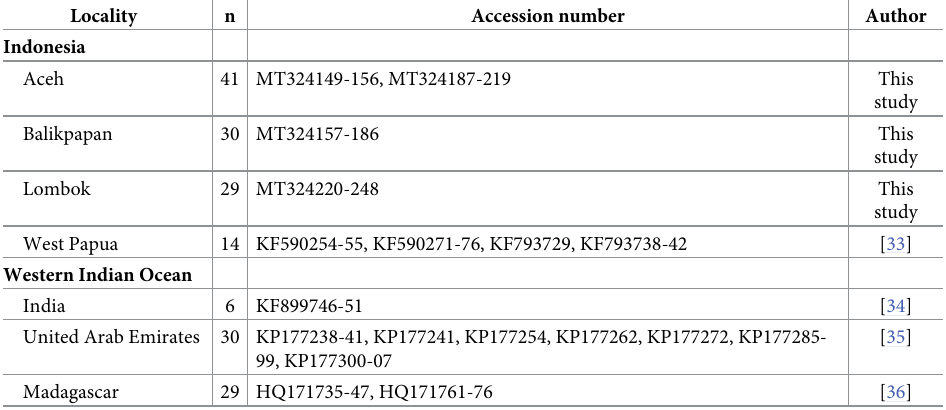
Table 2. Localities, the total number (n), and accession number of CO1 gene sequences of S . lewini from Aceh, Balikpapan, Lombok, and Western Papua (Indonesia), India, the United Arab Emirates, as well as Madagascar (Western Indian